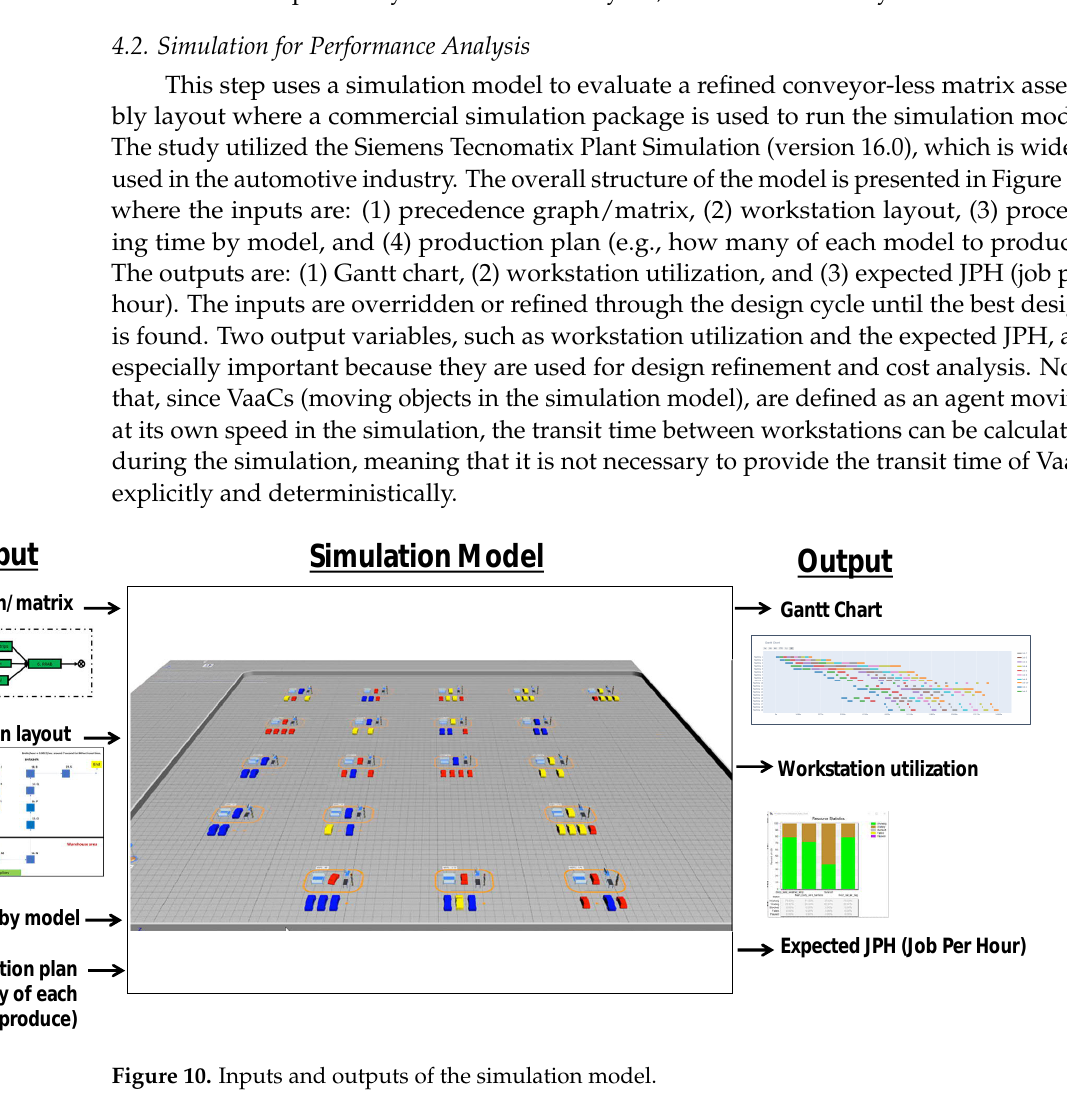
Figure 10. Inputs and outputs of the simulation model.